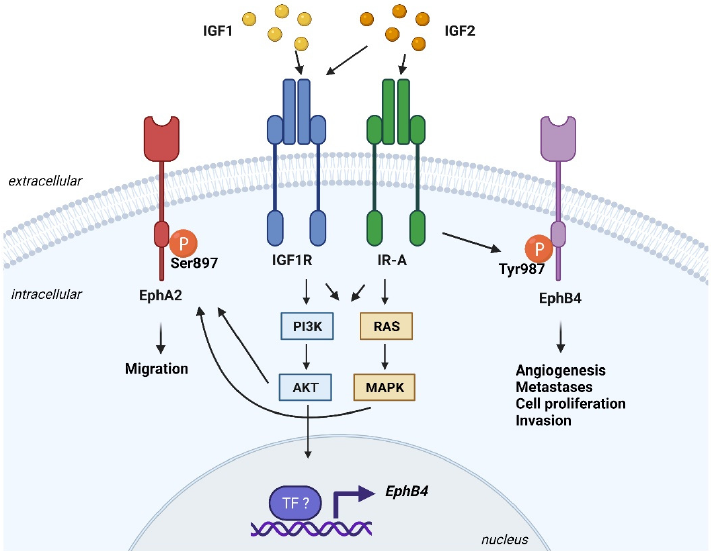
Figure 1. Schematic representation of the functional connections between the IGF system and the Ephrin axis in cancer. IGFs binding to their cognate receptors, IGF1R or IR-A, promote receptors phosphorylation and downstream activation of the PI3K/Akt pathway. Akt and MAPK phosphor- ylate EphA2 at Ser897 and promote ligand-independent activity of EphA2. The IR-A phosphorylates EphB4 at Tyr987, avoiding receptor ubiquitination and degradation, thereby maintaining EphB4 steady-state levels. mRNA expression of EphB4 is sustained by Akt-driven signals to the nucleus but the mechanism underlying this effect is not well characterized. Biological responses critical for cancer development and progression are reported .